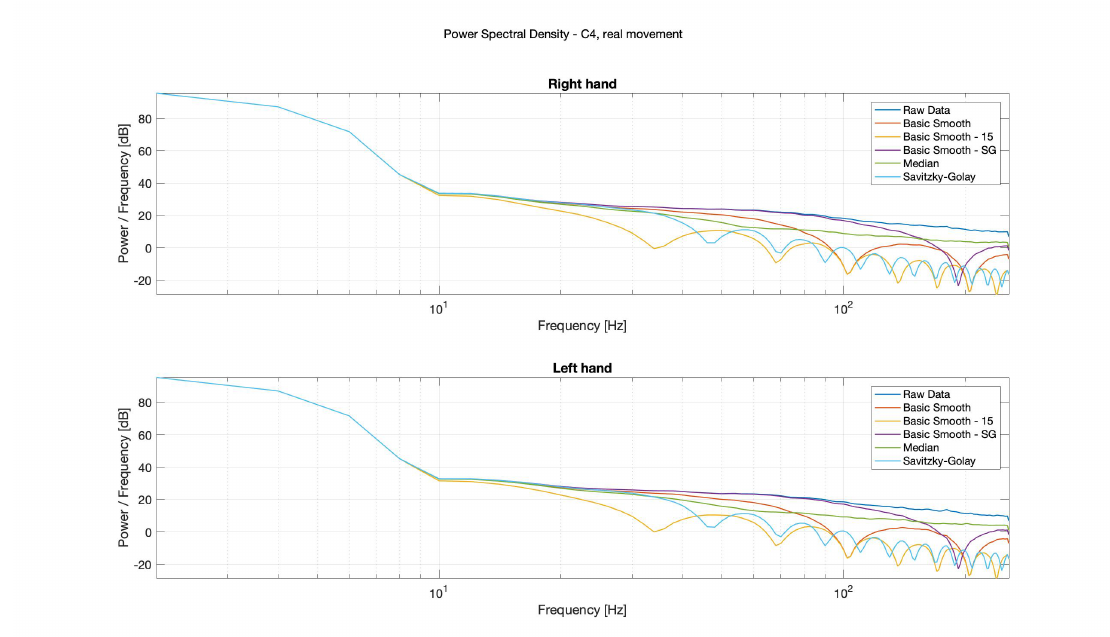
Figure 15. Power Spectral Density (PSD)—Bode plots, C4, real movement, right ( top ) and left ( bottom ) hands.